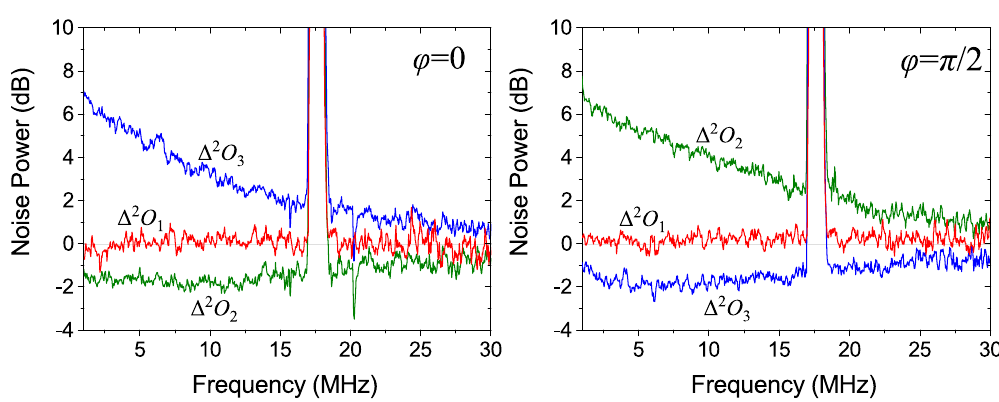
Figure 6. Noise power for the three orbital Stokes operators for OAM squeezed states with ϕ = 0 and ϕ = π